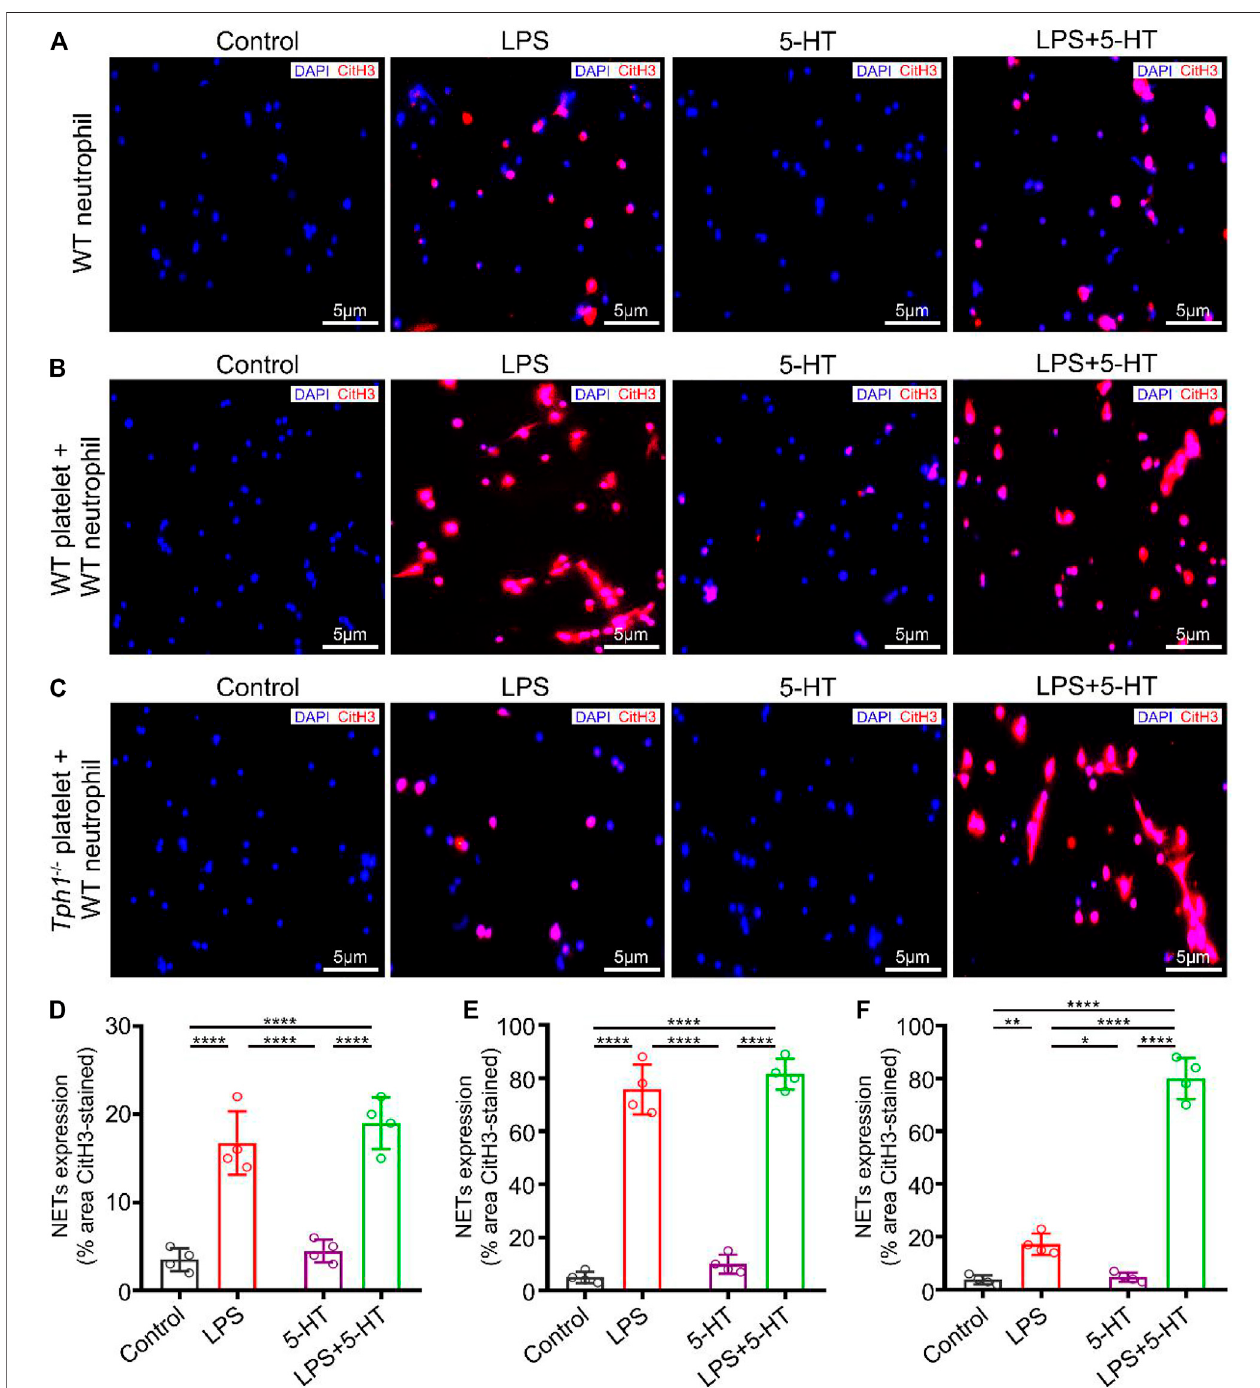
FIGURE 4 | Activated platelets promote NET formation through autocrine 5-HT. Neutrophils were isolated from WT mice. Platelets were isolated from WT and Tph1 − / − mice. The WT neutrophils were divided into WT neutrophil culture alone, WT neutrophil co-culture with WT platelet, and WT neutrophil co-culture with Tph1 − / − plateletgroups.Ineach group,cellswererandomlydividedintocontrol, lipopolysaccharide(LPS), 5-HT,and5-HT + LPSsubgroups.After12 hofcultivation,cellswere fi xed and co-stained with CitH3 fl uorescent antibodies and DAPI. The accumulation of NETs was detected by immuno fl uorescence microscopy. Representative images of NET formation are presented in this fi gure. (A) Representative images of NET formation in WT neutrophils cultured alone. (B) Representative images of NET formationinWTneutrophilsco-culturedwithWTplatelets. (C) RepresentativeimagesofNETformationinWTneutrophilsco-culturedwith Tph1 − / − platelets. (D) Analysis of NET expression in WT neutrophils. (E) Analysis of NET expression in WT neutrophils co-cultured with WT platelets. (F) Analysis of NET expression in WT neutrophils co-cultured with Tph1 − / − platelets. For each group: n (cid:2) 4. *p < 0.05, **p < 0.01, ***p < 0.001, and ****p < 0.0001.